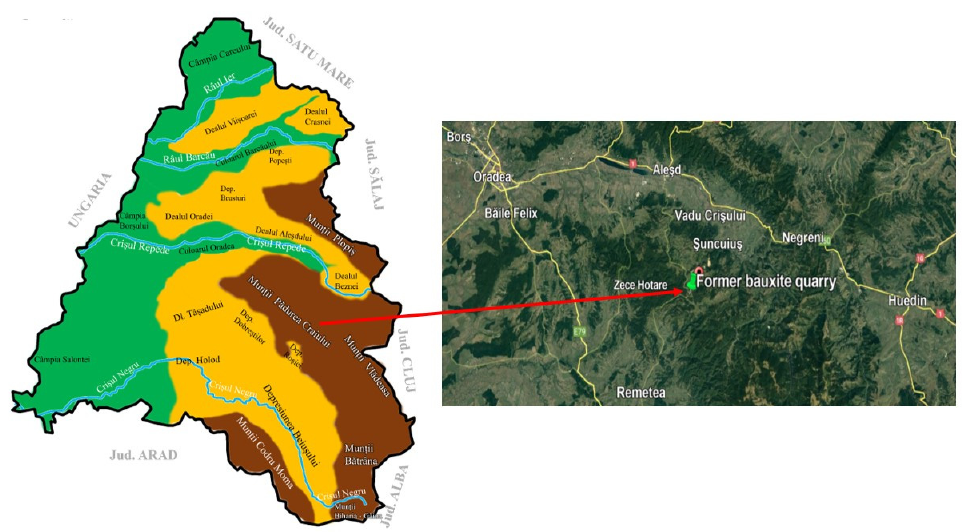
Figure 1. Location of the research area [17,18].